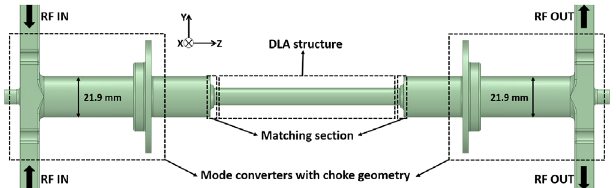
FIG. 1. Conceptual illustration of an externally powered DLA structure connected with two matching sections and two TE 10 -TM 01 mode converters with choke